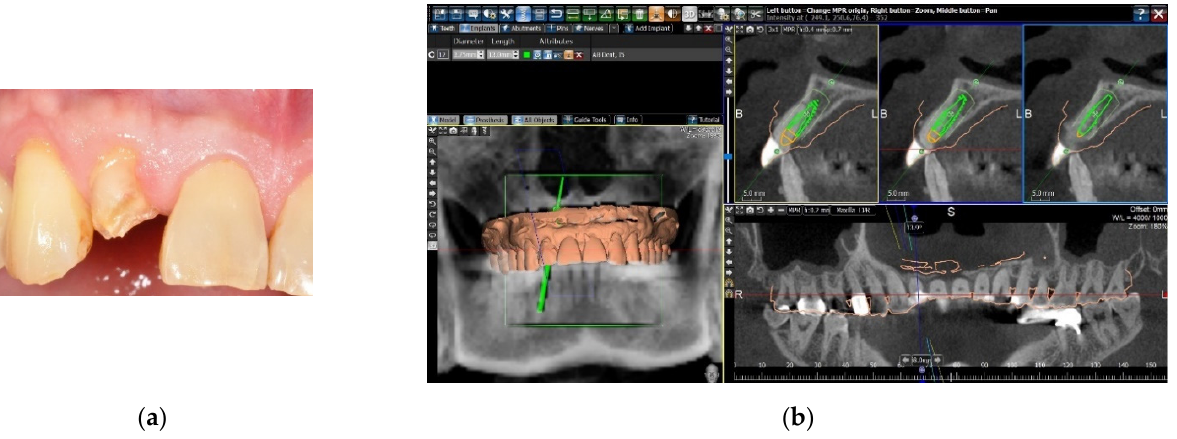
Figure 1. Matching the digital dental cast and the CBCT scan by registration of dental surface images. ( a ) A patient with a fractured right maxillary lateral incisor. ( b ) The digital dental cast and the CBCT scan were superimposed by setting registration points on the corresponding dental surfaces of the two digital images.